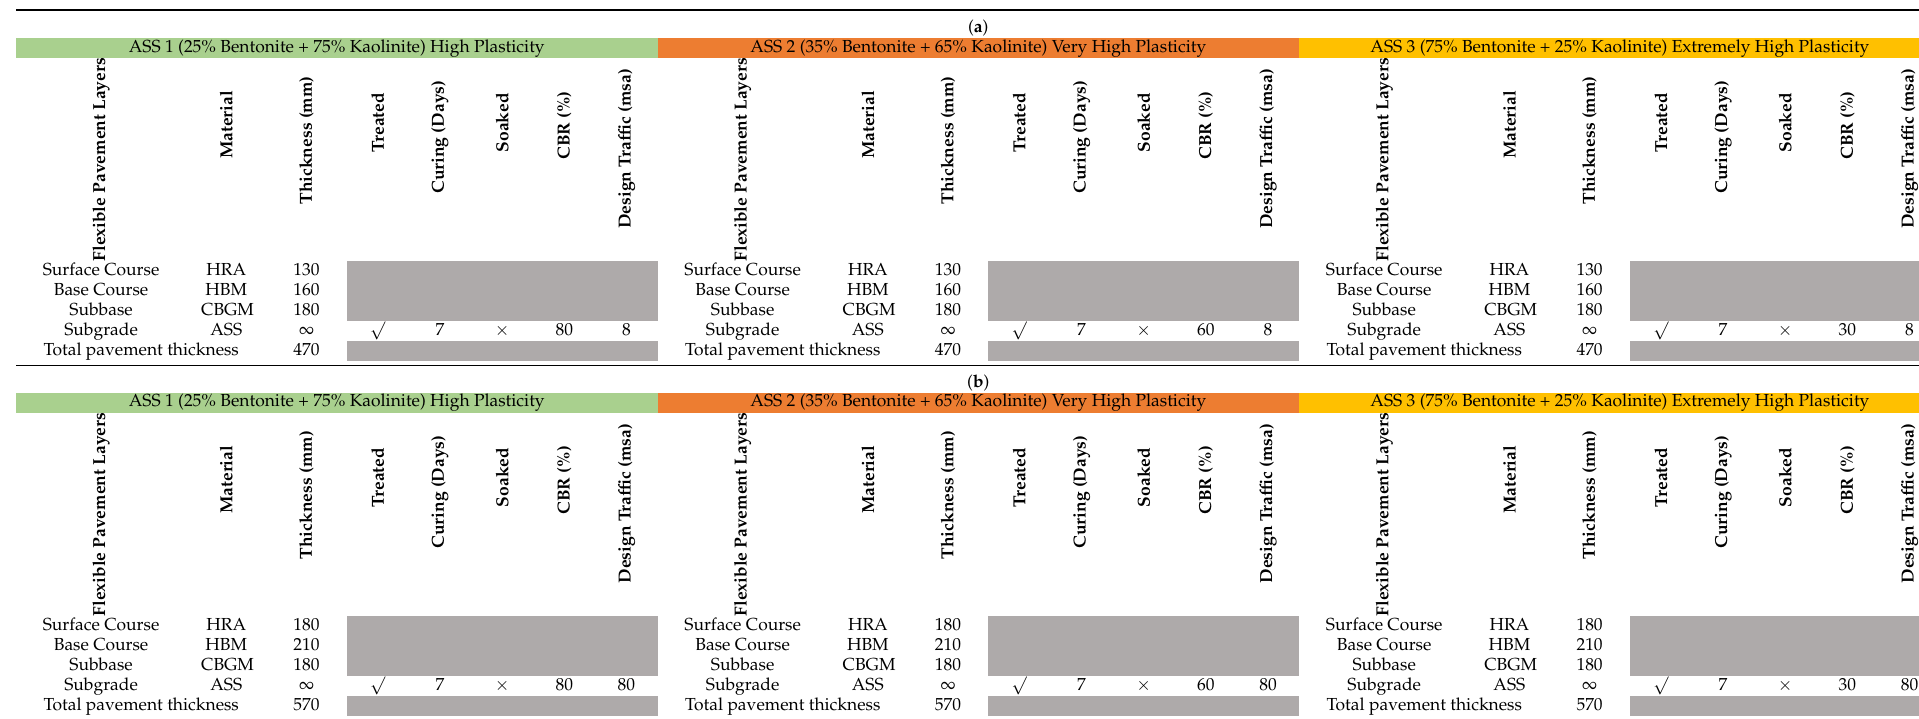
Table 4. ( a ) DMRB pavement design for traffic load 8 msa. ( b ) DMRB pavement design for traffic load 80 msa. ( c ) DMRB pavement design for traffic load 8